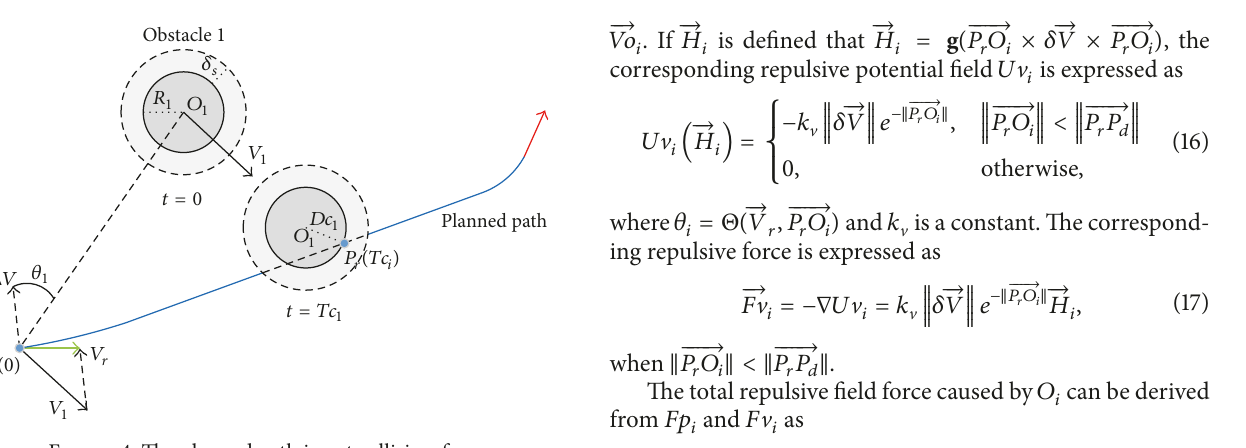
Figure 4: The planned path is not